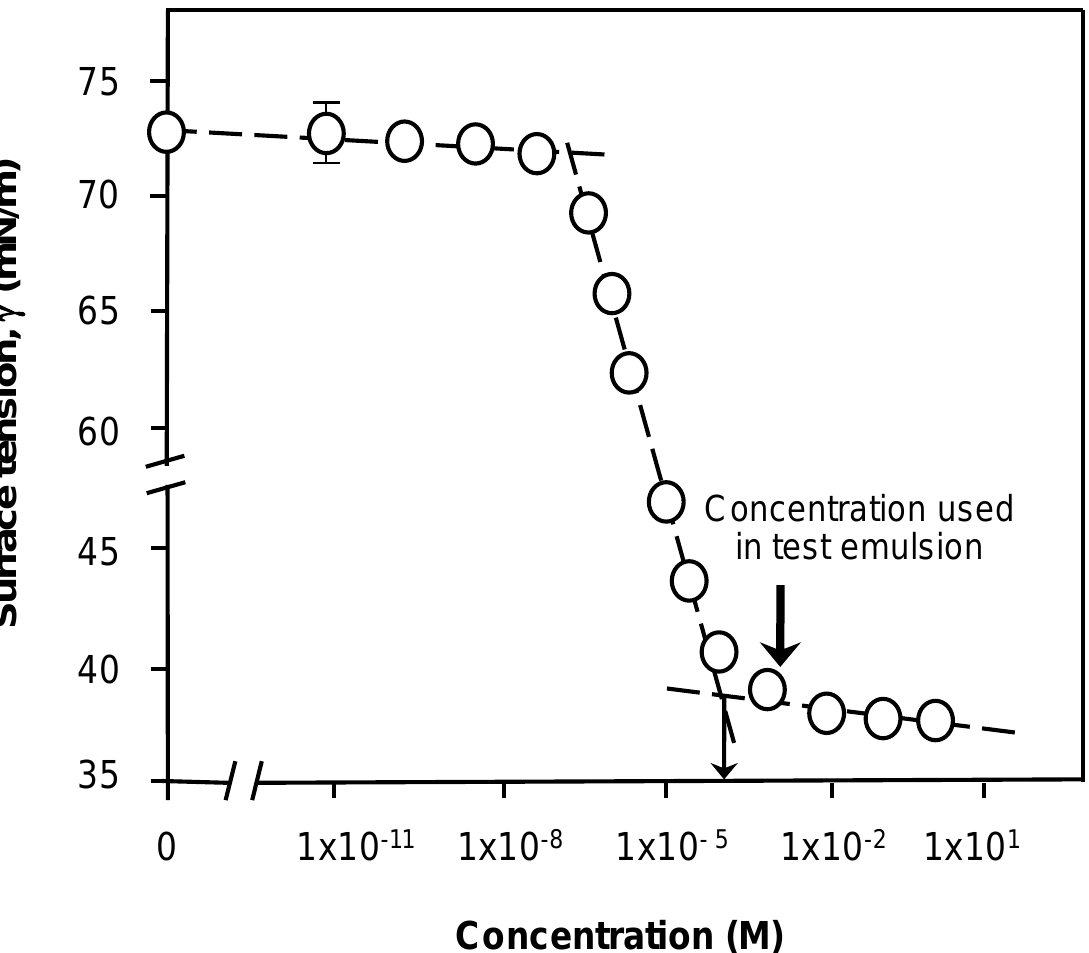
Figure 1. Surface tension for purified Tween 80 solutions at 20 ◦ C as a function of increasing bulk concentration (where error bars are not shown they are of a smaller magnitude than the dimensions of the symbols; lines represent an aid to the eye to show the trend in the data). The arrow in the figure indicates the concentration used in test emulsion. All solutions used for samples were prepared from surface chemically pure 50 mM sodium phosphate buffered water, pH